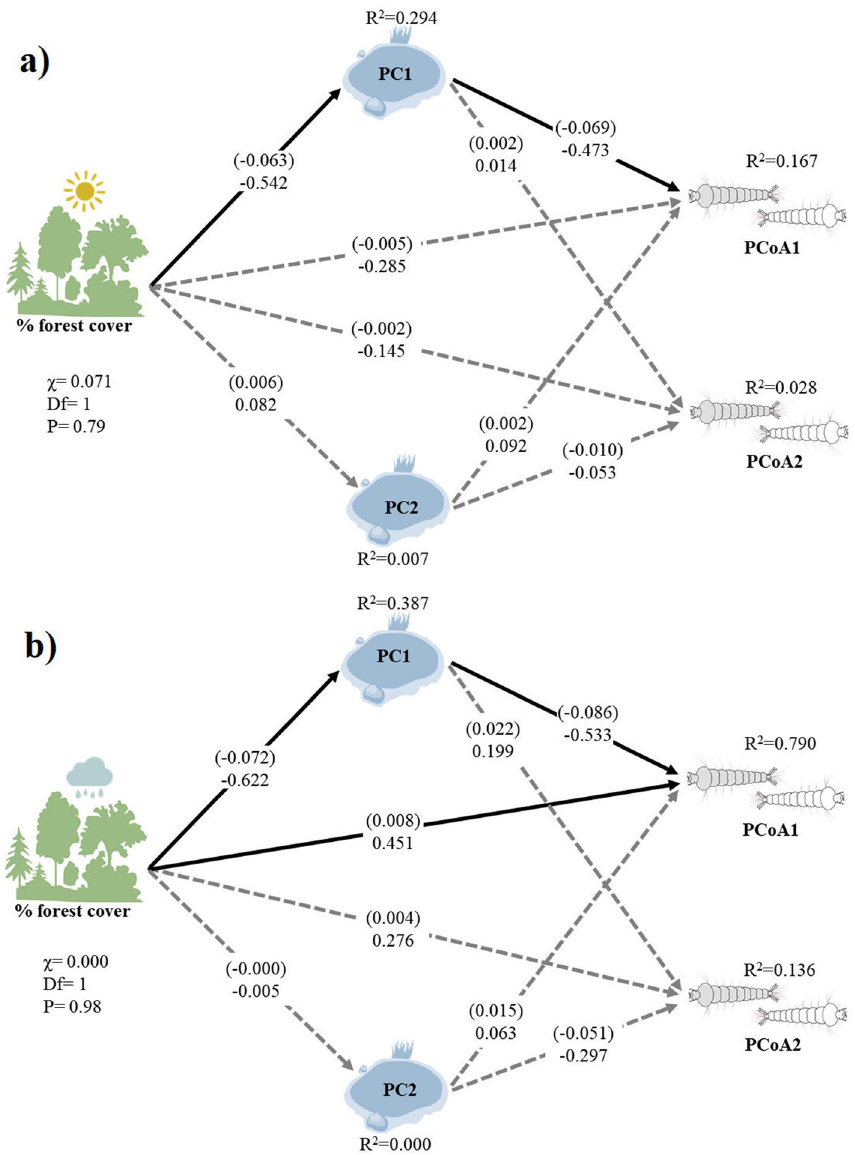
Figure 5. Schematic representation of dry (a) and rainy (b) season SEM results. The continuous arrows indicate significant paths and the dashed arrows indicate insignificant paths; PC1 and PC2 are the scores of the ordination of site water quality variables and PCoA1 and PCoA2 represent larval anopheline assemblage composition captured by PCoA. R2 values are reported for each endogenous variable and non-standardized and standardized (in parentheses) coefficients are indicated on each path. The image was created using Abode Illustrator 2020 (https:// www. adobe. com/ br/ produ cts/ illus